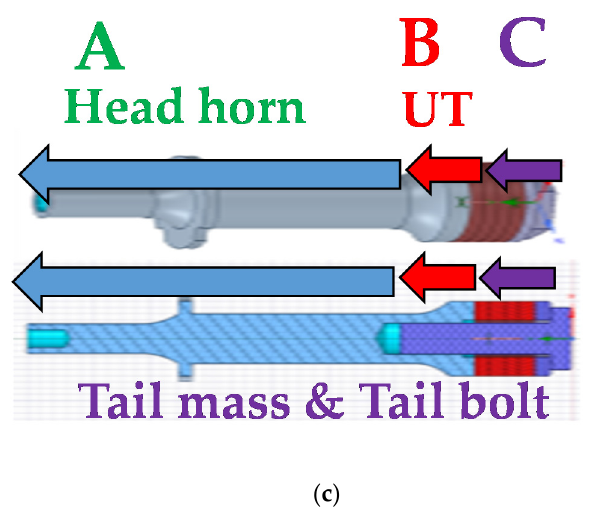
Figure 1. ( a ) Schematic diagram to describe the overall methodology for the developed WUSS. ( b ) Optimization procedure of the UT and ( c ) three-dimensional (3D) model for the UT with head horn, and tail mass and bolt design.